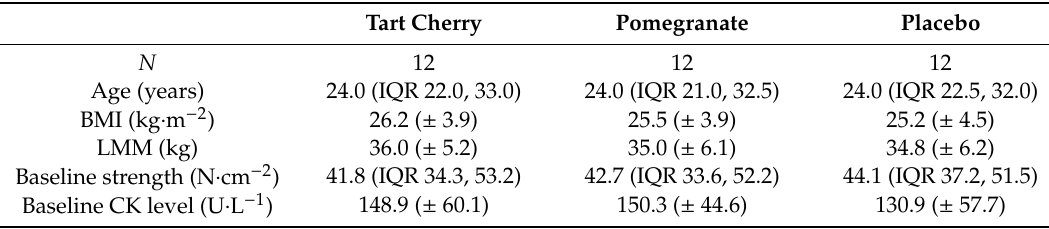
Table 1. Participant characteristics ( n =